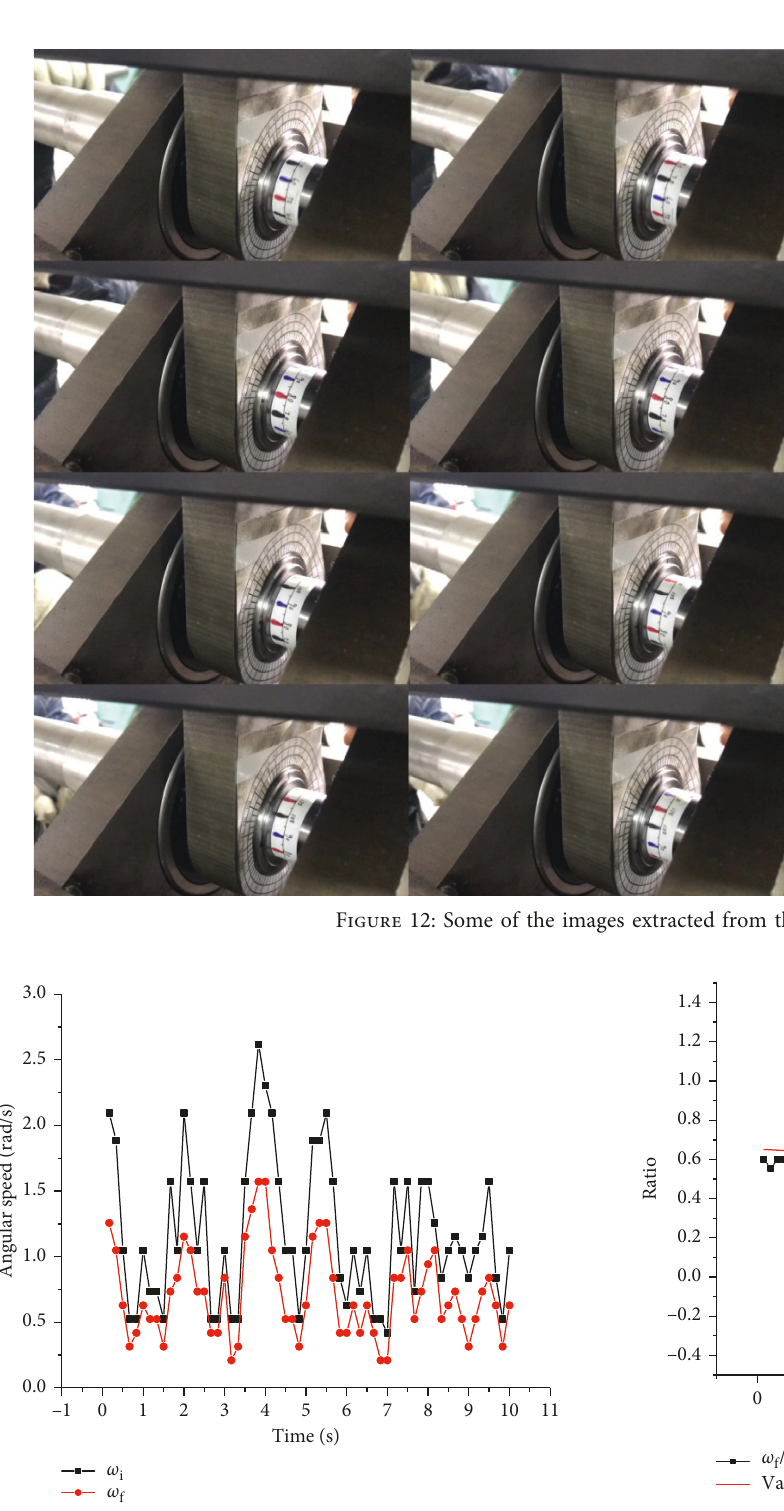
Figure 13: Angular speeds of the sleeve (with 12 rollers) and the shaft.